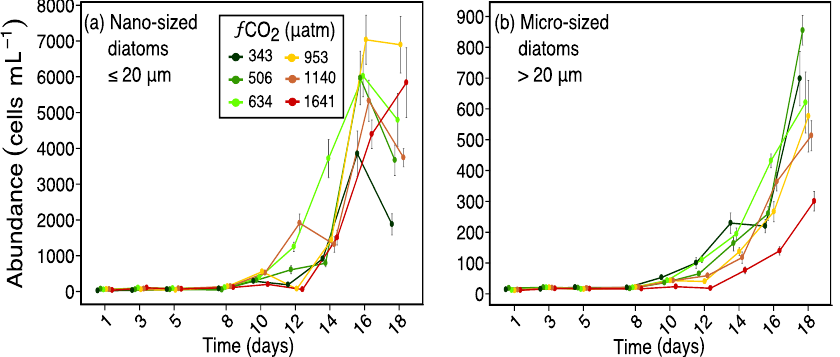
Figure 2. Abundances of (a) nano-sized diatoms (longest length ≤ 20µm), and (b) micro-sized diatoms (longest length > 20µm) over days 1 to 18 of the incubation of a natural protistan community in tanks maintained at different f CO 2 levels. Error bars are standard errors derived from pseudo-replicates undertaken at each time point for each